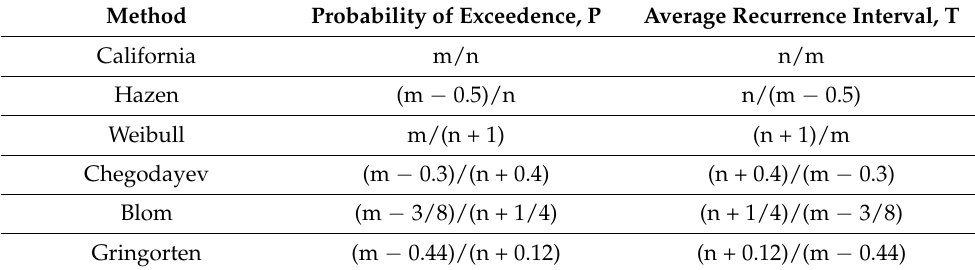
Table A1. Plotting position formula [61].